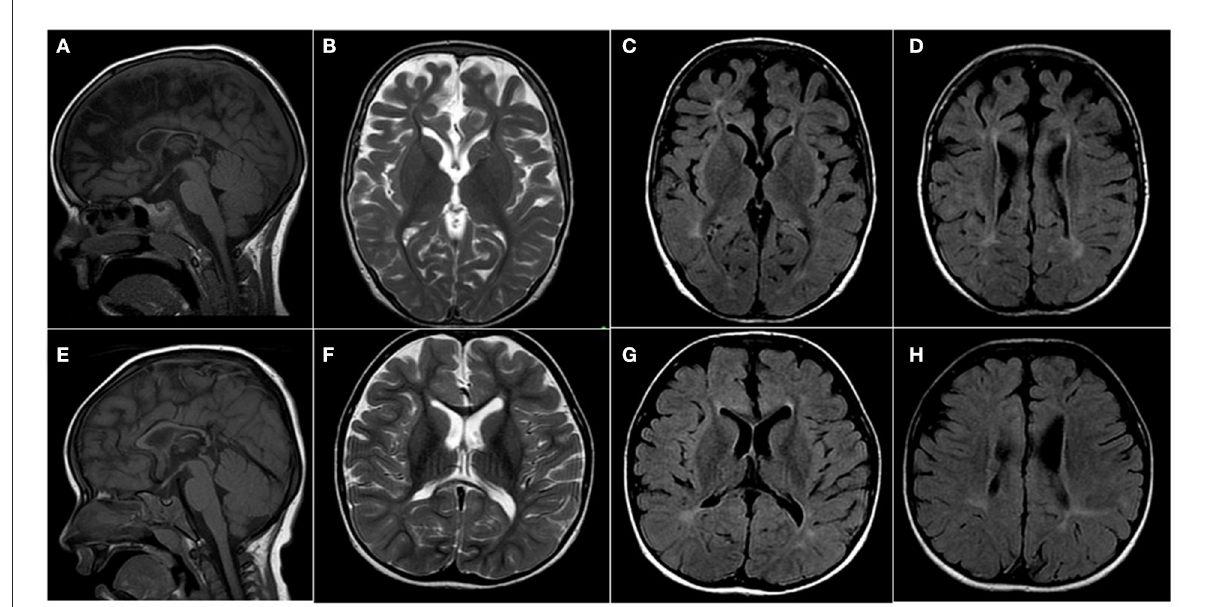
FIGURE1 Brain imaging of subjects with PLPHP deficiency. MRI of subjects 2 (A–D) and 3 (E,F) at 4.5 and 2.5 years. (A,E) Sagittal T1 demonstrates thin corpus callosum. (B,F) Axial views show a patchy bilateral increase in T2 and (C,D,G,H) FLAIR signal in the deep white matter around the ventricles at bilateral frontal and bilateral peritrigonal regions. Both subjects have cerebral atrophy, most noted in subject 2, with a prominence of CSF spaces, particularly over frontal and sylvian regions